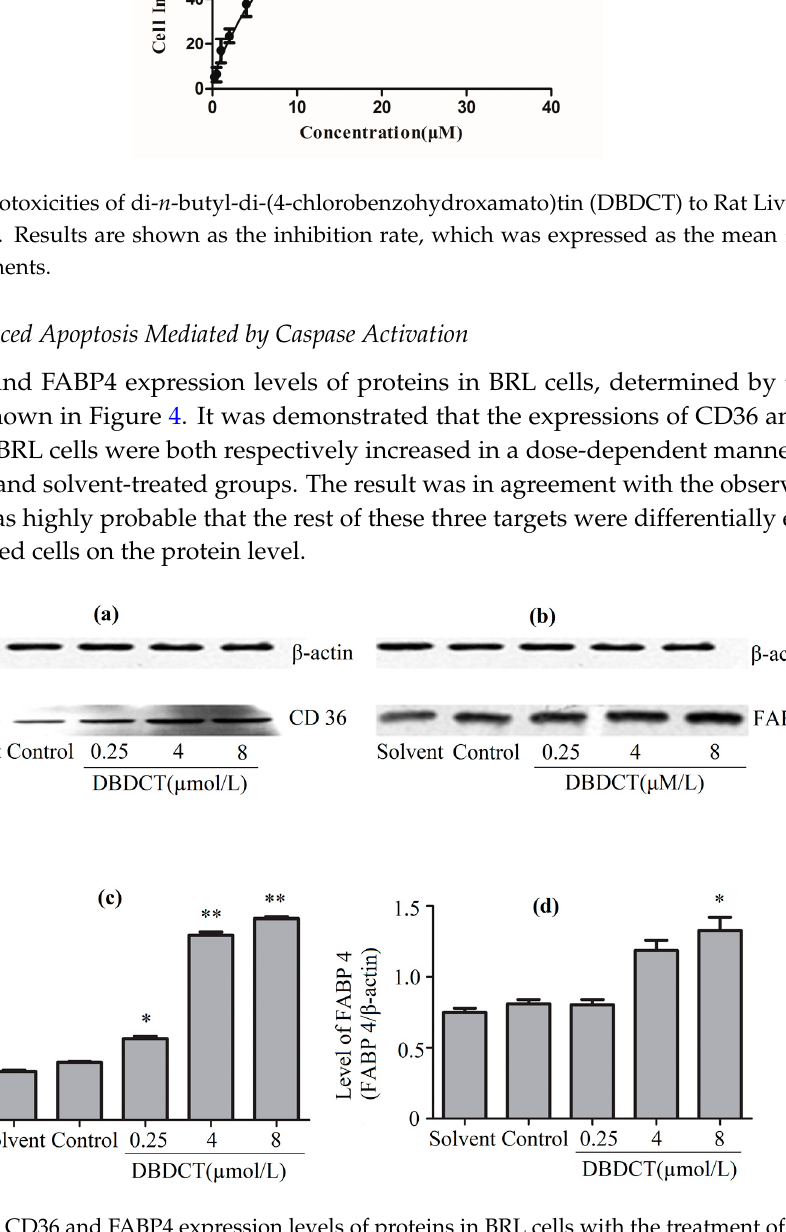
Figure 4. The CD36 and FABP4 expression levels of proteins in BRL cells with the treatment of DBDCT (0.25, 4, and 8 µ mol/L). ( a , b ) The Western blot results; ( c , d ) Relative protein expression level of CD36 and FABP4 in cells. The results are expressed as a ratio of the expression levels of the reference protein β -actin (* p < 0.05; ** p < 0.01; compared with control group).